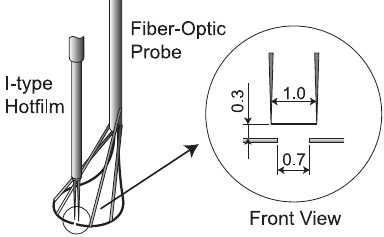
Fig. 2 The combined probe for the simultaneous